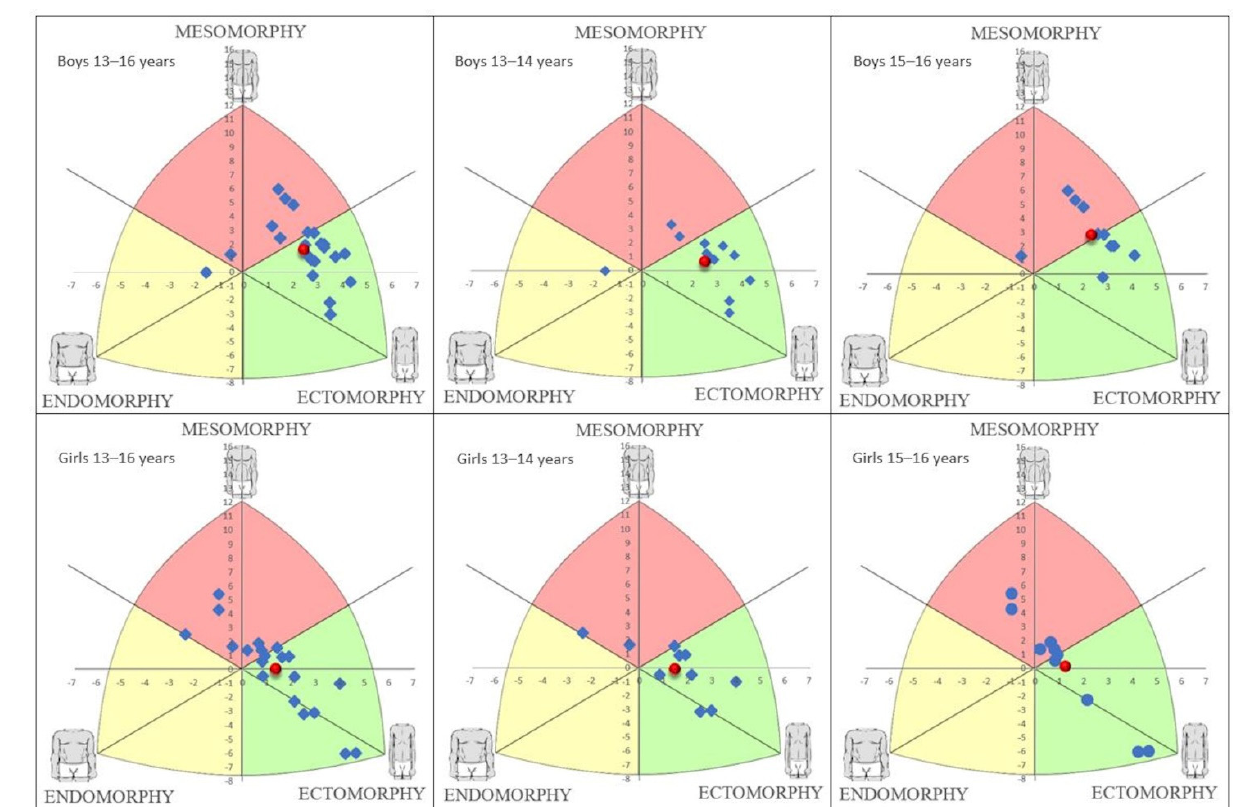
Figure 1. Somatotype distribution in the different groups of boys and girls.